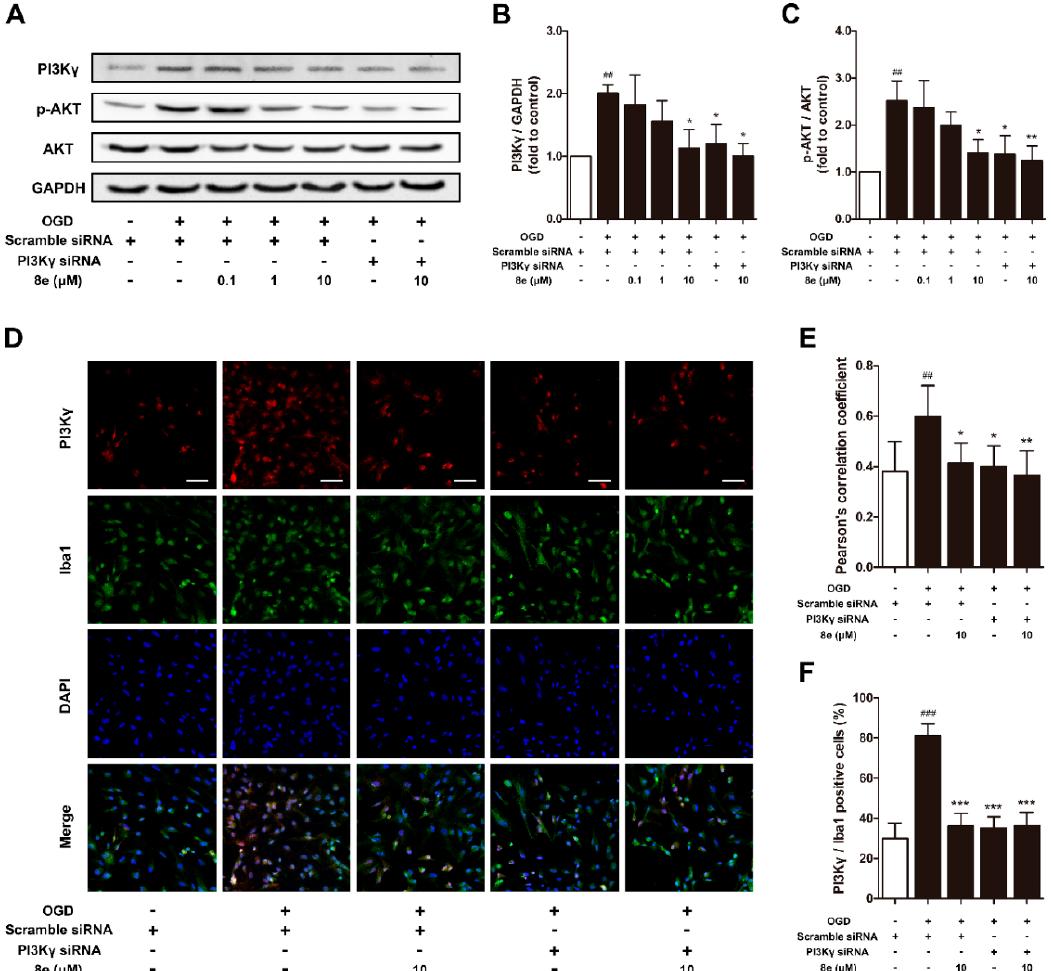
Figure 6. 8e downregulated PI3K γ signaling in primary microglial cells at 24 h after oxygen–glucose deprivation (OGD). ( A ) Representative bands of Western blot for PI3K γ , AKT and p-AKT in primary microglia; ( B , C ) semiquantitative analysis of PI3K γ and p-AKT protein levels; ( D ) representative confocal fluorescence images of primary microglia labeled with PI3K γ (red), Iba1 (green) antibodies and DAPI (blue). Scale bar = 50 μ m; ( E ) Pearson’s correlation coefficients between PI3K γ (red) and Iba1 (green) fluorescence; ( F ) quantitative analysis of the percentage ratios of PI3K γ /Iba1 positive cells to Iba1 positive cells. Data are presented as mean ± SD ( n = 3). ## p < 0.01, ### p < 0.001 vs. control group. * p < 0.05, ** p < 0.01, *** p < 0.001 vs. OGD group.